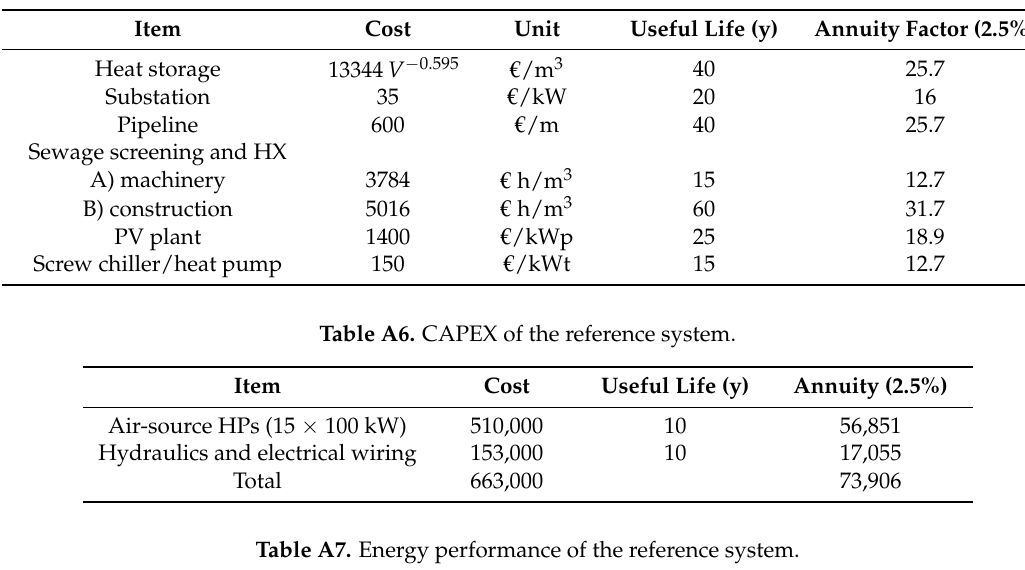
Table A7. Energy performance of the reference system. Figure